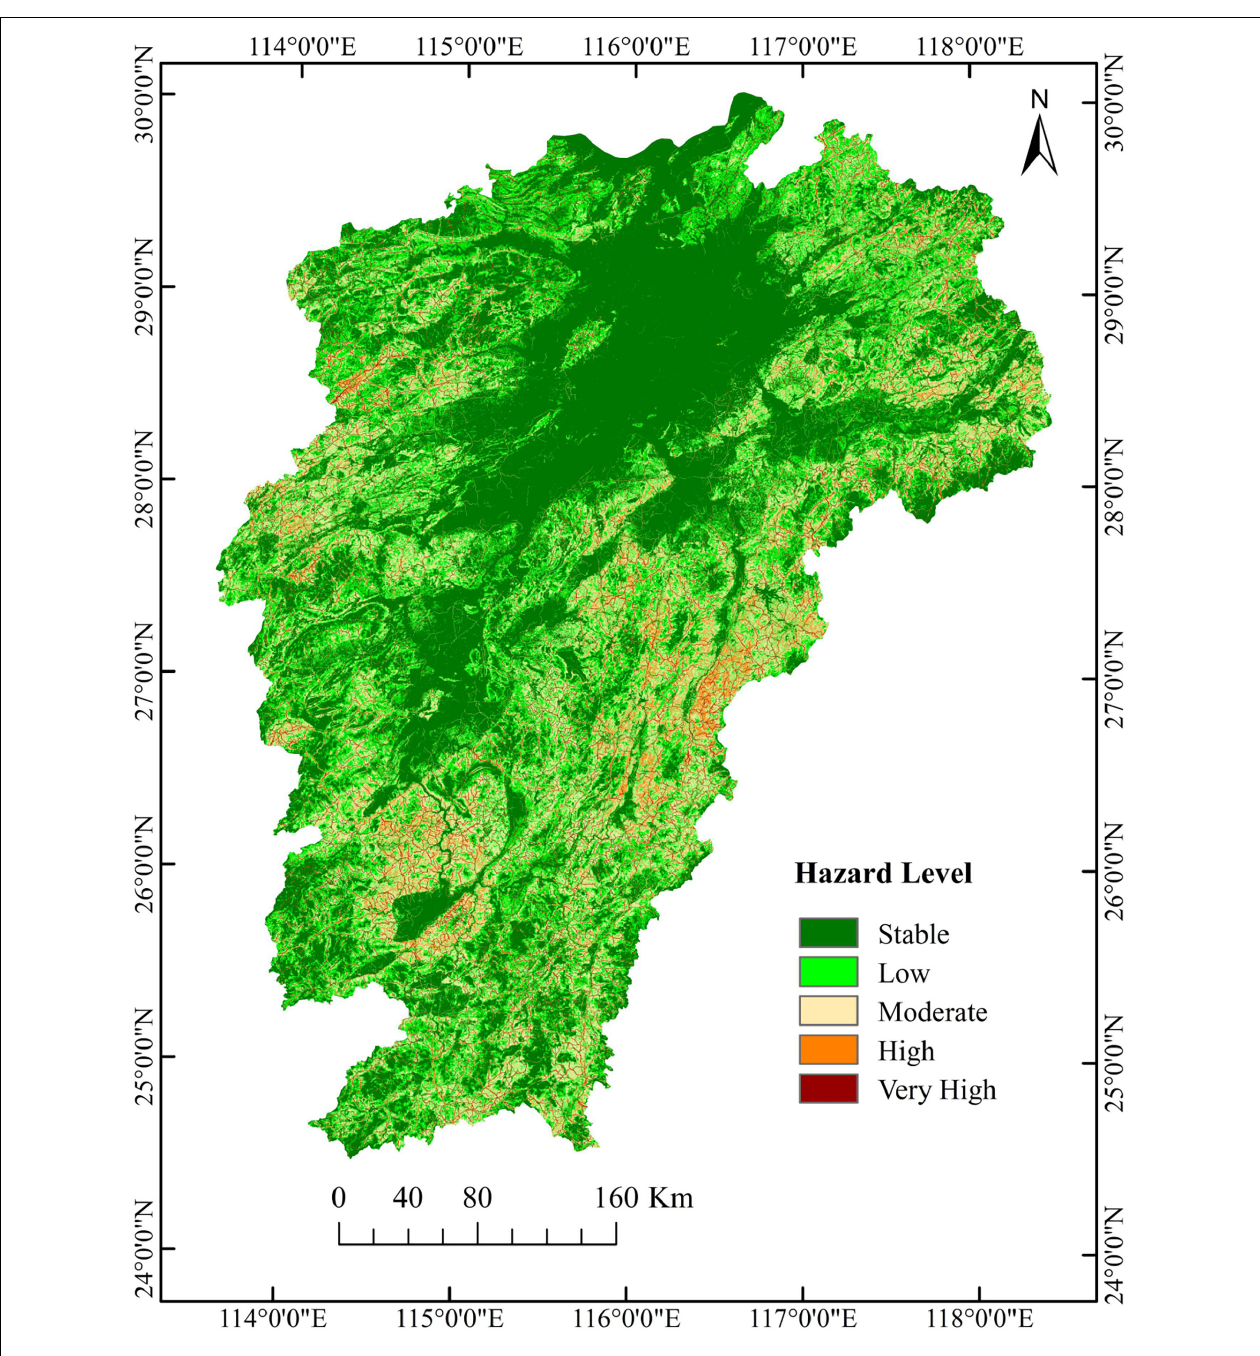
FIGURE 4 | Landslide hazard map of Jiangxi derived from a logistic regression model with complete linear features ( Table 5 ).